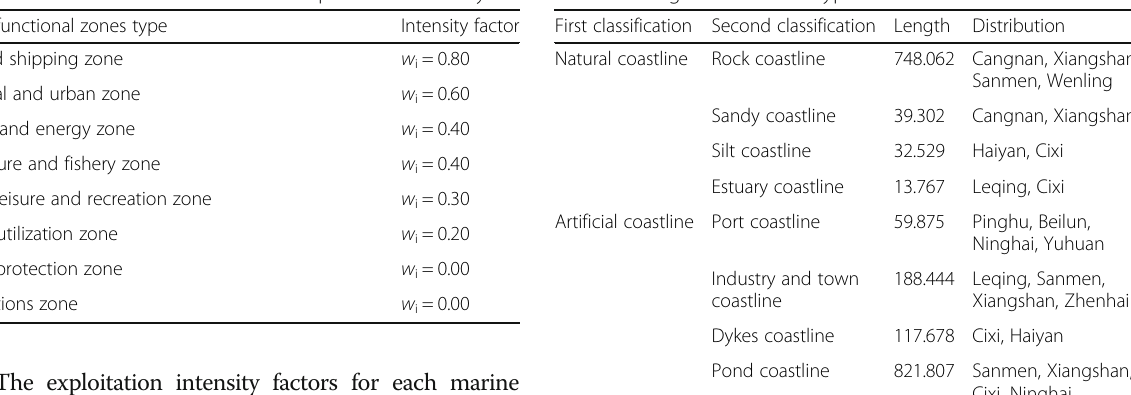
Table 5 Marine functional zone and its exploitation intensity Table 6 Length of coastline types and its distribution